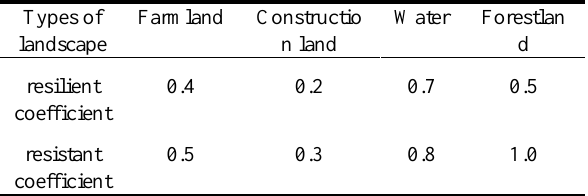
Table 2. Each landscape type resilience coefficient and resistance coefficient.